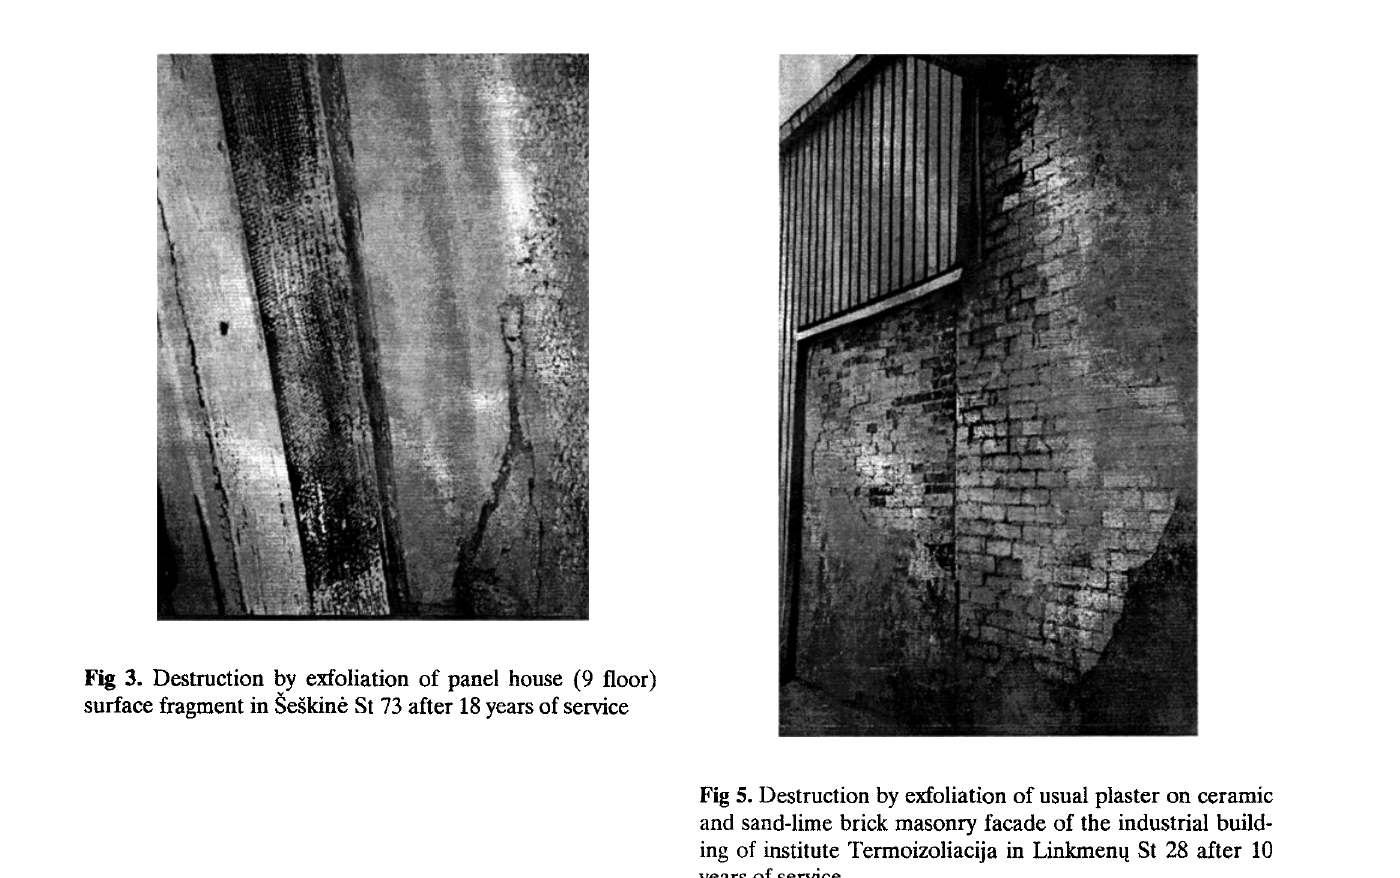
Fig 5. Destruction by exfoliation of usual plaster on ceramic and sand-lime brick masonry facade of the industrial build-